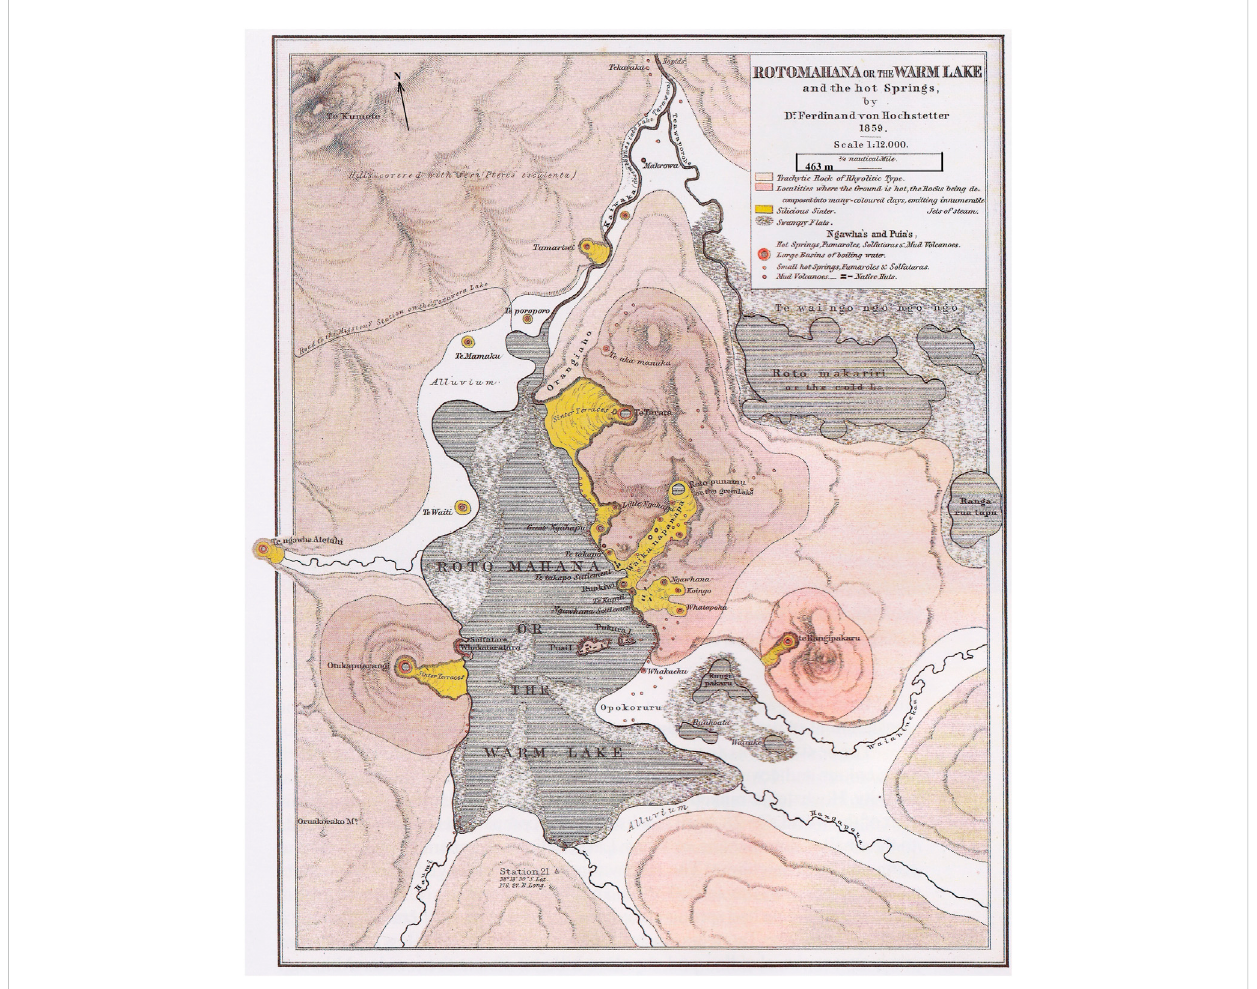
FIGURE 2 Map of Lake Rotomahana from the English edition of Hochstetter & Petermann ’ s Geological and Topographical Atlas of New Zealand, showing streams entering and leaving the lakes. Note the orientation from the north arrow (Hochstetter and Petermann,